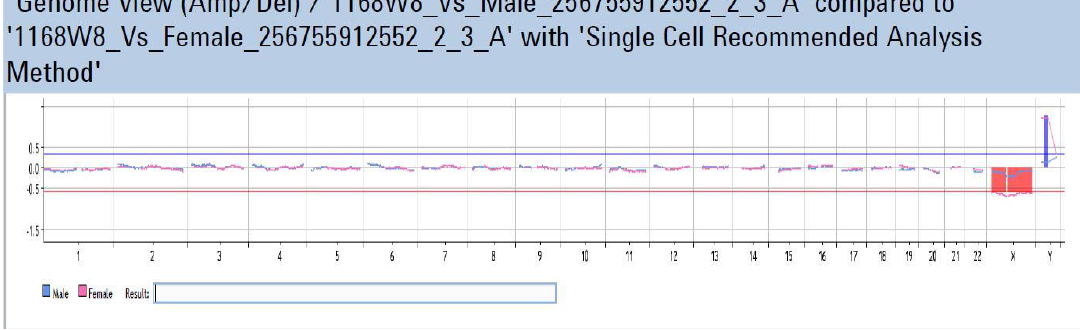
Figure A6. Male embryo, euploid, exon 5, c.385G>A.